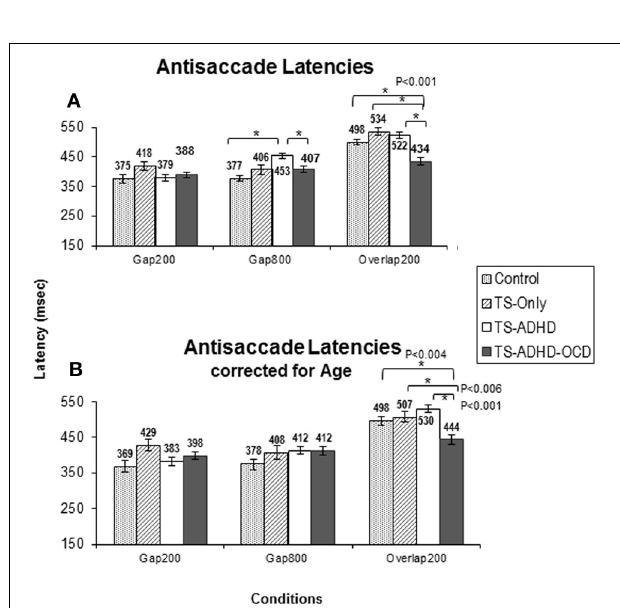
FIGURE 2 | Antisaccade latency. The top graph (A) shows the mean antisaccade latency of each group: Control, Tourette-only (TS-only), TS + Attention Deficit Hyperactivity Disorder (TS + ADHD) and TS + ADHD + Obsessive Compulsive Disorder (TS + ADHD + OCD) in each fixation offset condition. The expected longer saccade latency in the Gap800 condition relative to Gap200 and Overlap200 is not observed here. This pattern remains the same following Age-adjustments of each group in the bottom graph (B) . The shorter saccadic latency of the TS + ADHD + OCD group relative to the other groups is still present following Age-adjustments in the Overlap200 condition (B) . The error bars display standard errors.